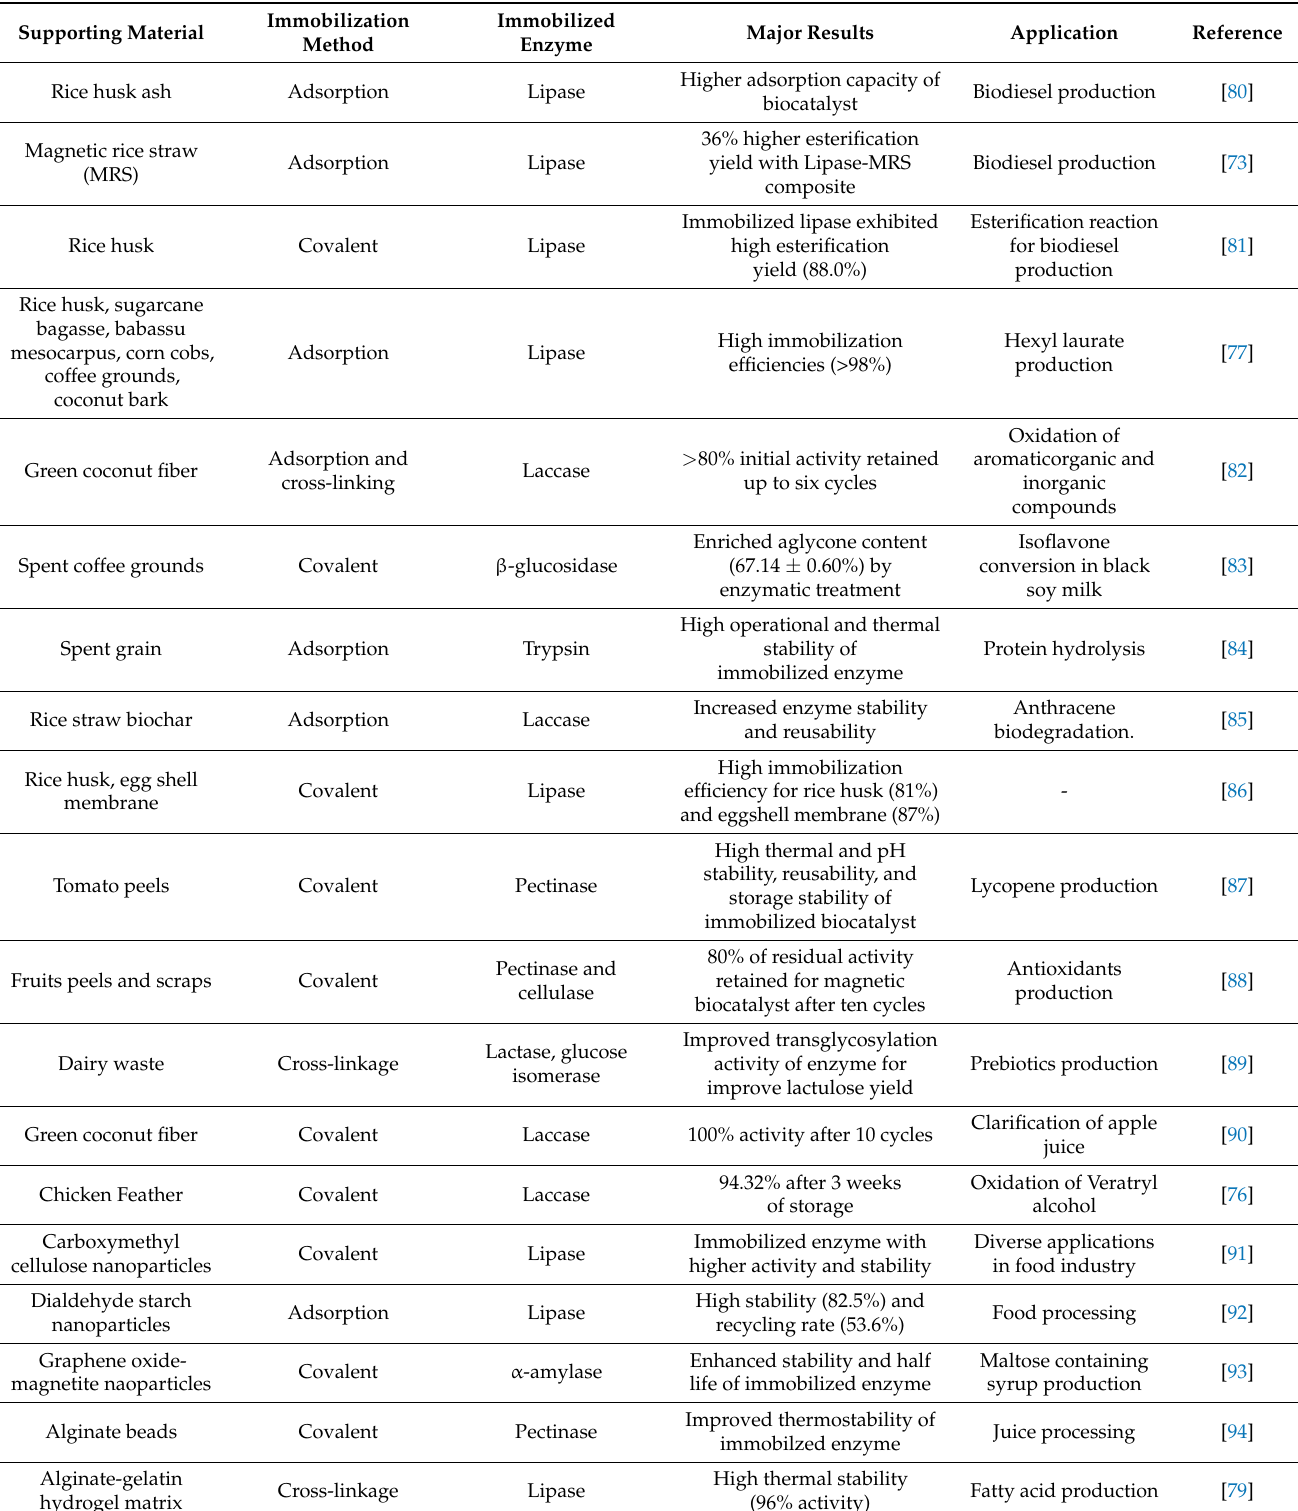
Table 1. Enzyme immobilization by different supporting